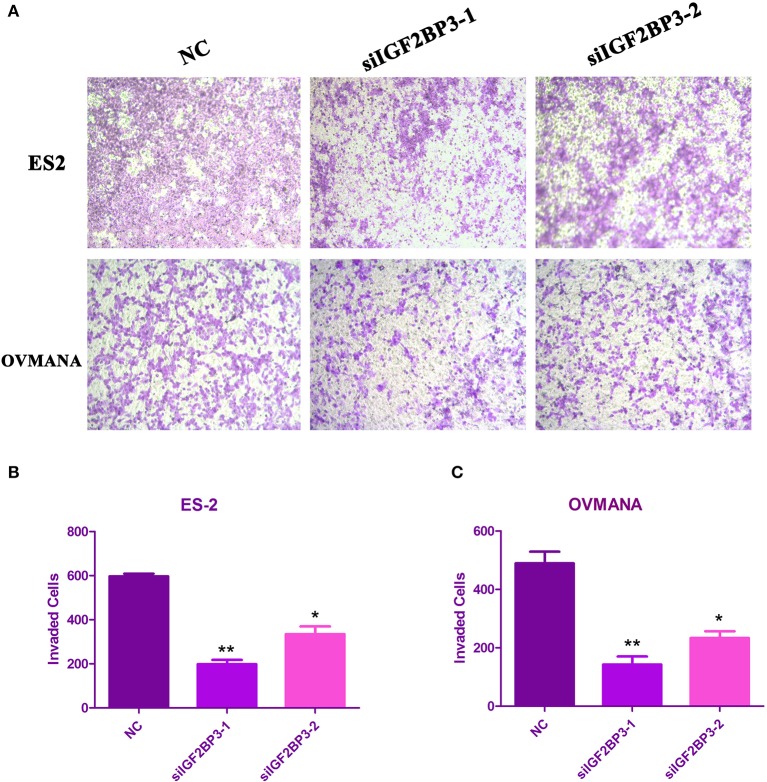
Effects of siIGF2BP3 on OCCC cell invasion. (A) ES2 and OVMANA cells were plated in the upper chamber with NC, siIGF2BP3-1, or siIGF2BP3-2. Pictures were taken under the microscope after 48 h of treatments. (B,C) Quantitation of invading cells. Results were obtained from three independent experiments, *P < 0.05, **P < 0.01, compared with NC.